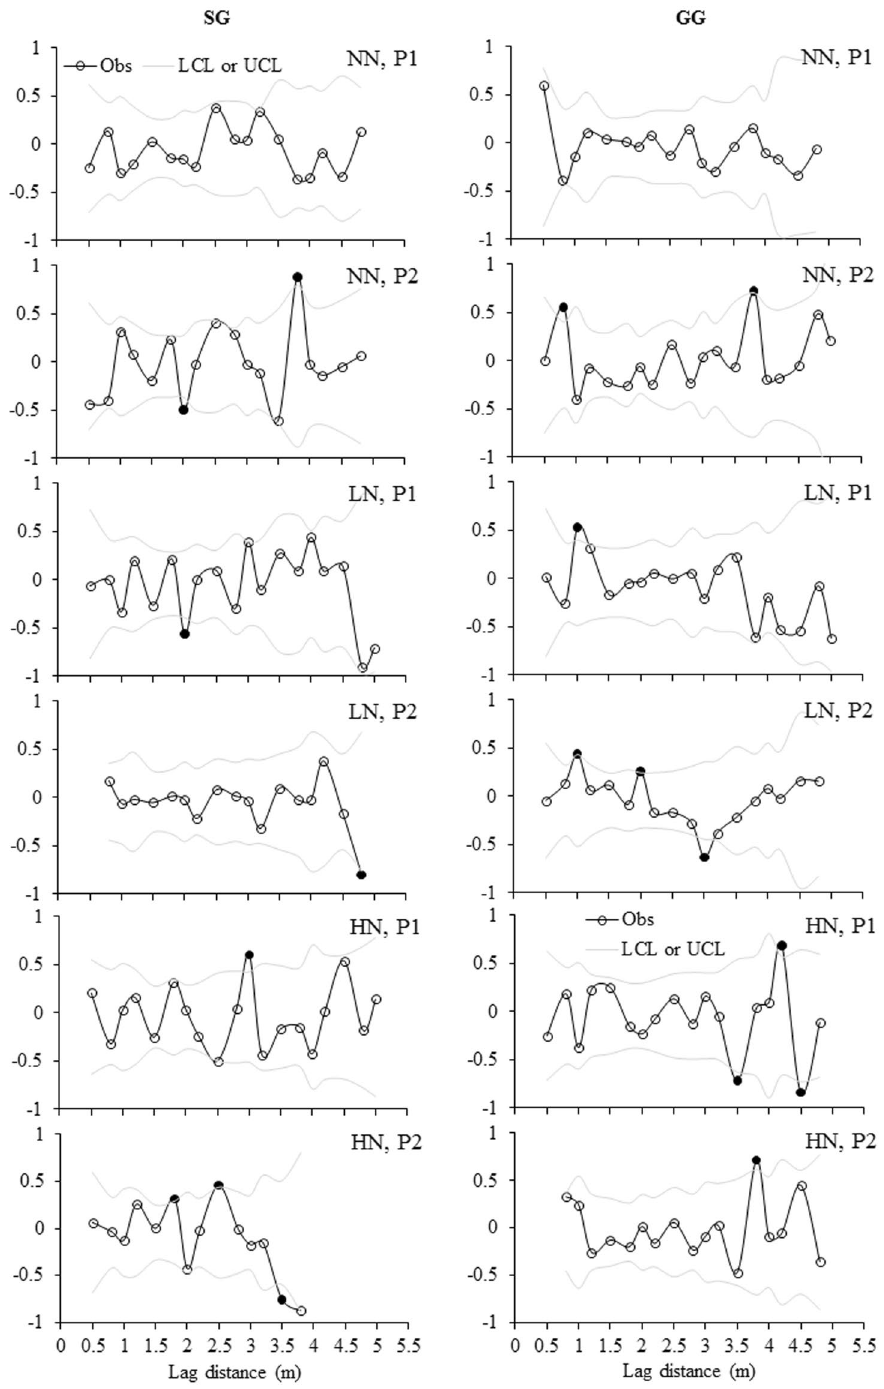
Figure 7. Moran’s I correlograms for soil MBC:MBN under three N fertilization treatments (i.e. NN, LN and HN) in SG and GG cropland soils in a three-year long fertilization experimental site at the Tennessee State University (TSU) Agricultural Research Center in Nashville, TN, USA. Filled circles denote Moran’s I values that exhibited significant positive or negative autocorrelation. Obs: observations; LCL: low confident limit; and UCL: Upper confidence limit. Other abbreviations are referred to Table